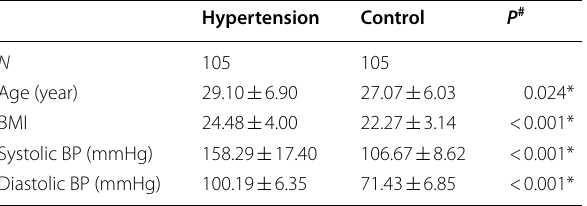
Table 1 Characteristics of subjects in the hypertension in pregnancy and control groups